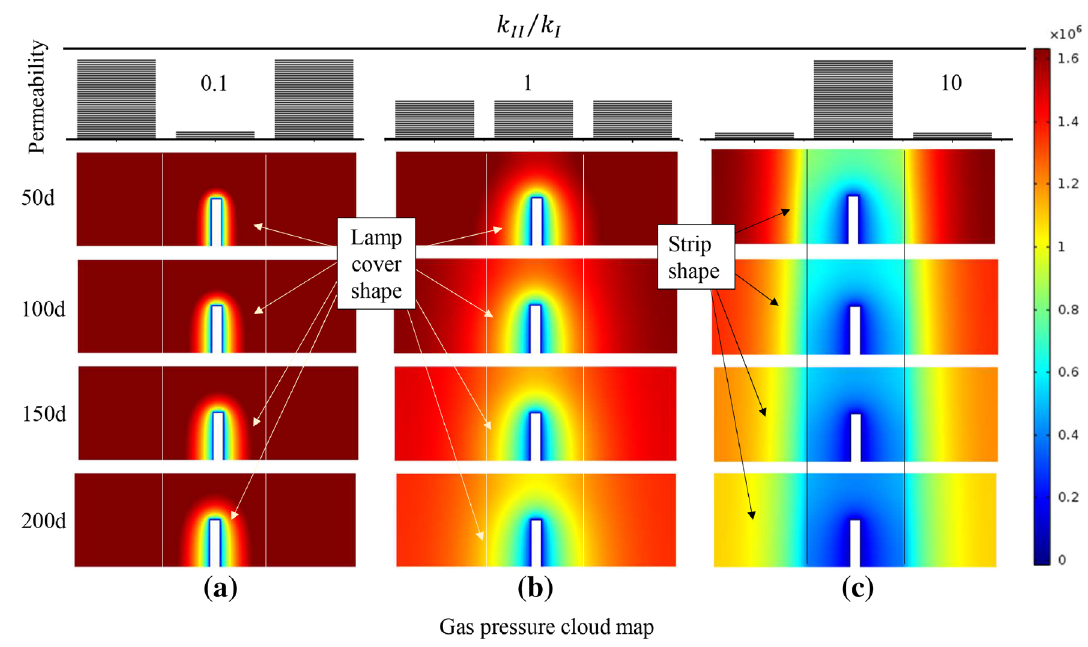
Fig. 4 Cloud map of gas distribution in the whole